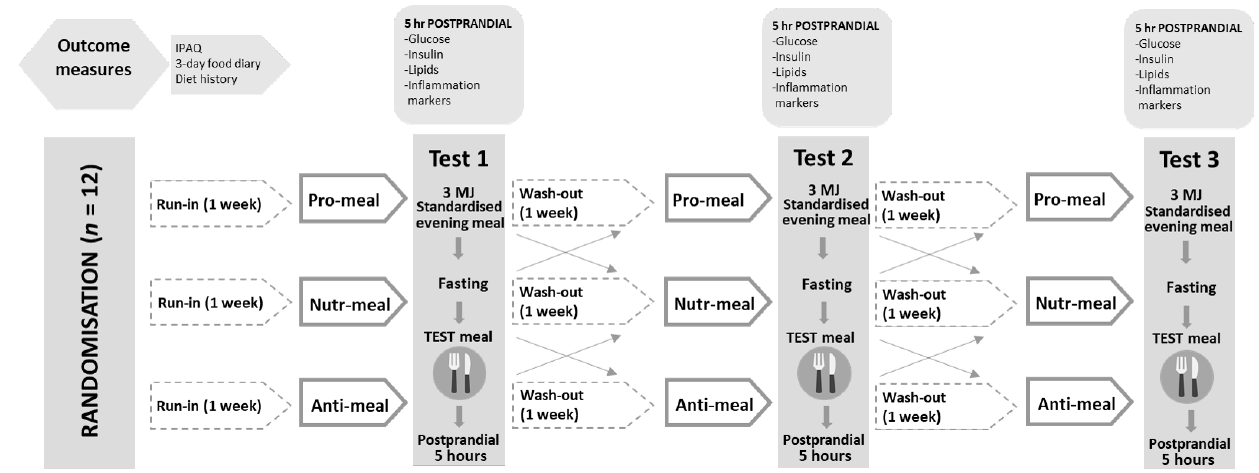
Figure 1. Crossover study design. IPAQ: International Physical Activity Questionnaire.